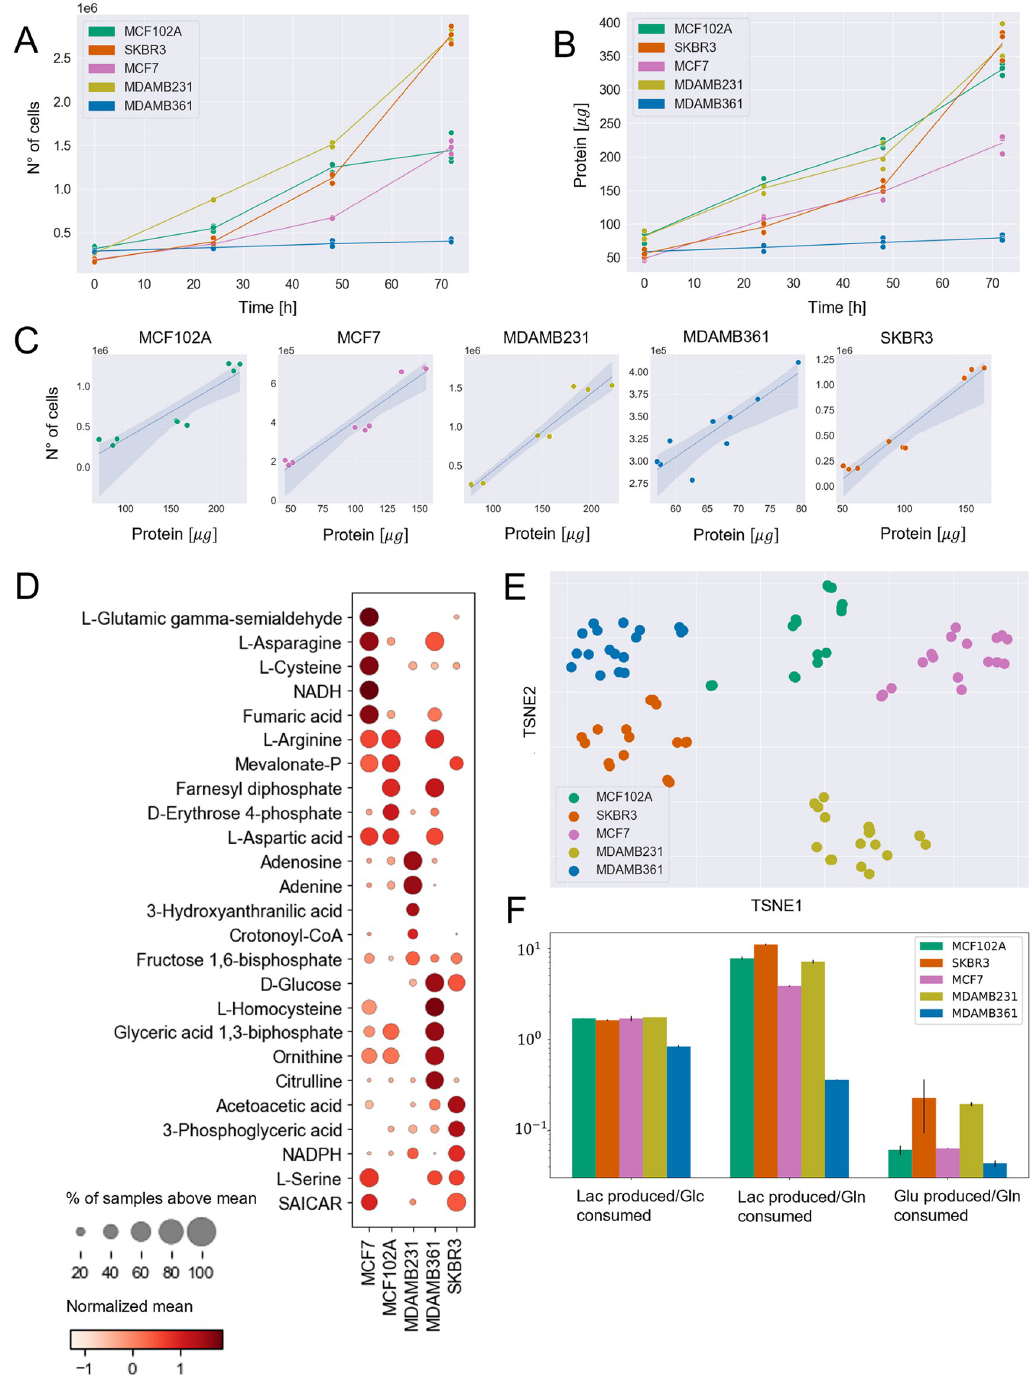
Fig 2. Experimental metabolic measurements at balanced growth phase. A) Number of cells in time. B) Protein content in time. C) Correlation plots between protein content and number of cells for experimental observations in the 0–48hrs time windows. D) Dot plot representing the normalized mean (Z-score) of the metabolite abundances within each line (visualized by color) and the fraction of samples of each cell line with the abundance over the mean of all cell lines samples (visualized by the size of the dot). The first five metabolites that better distinguish each cell line from the others, according to t-test p-value, are reported. E) t-SNE dimensionality reduction of intracellular metabolomics profiles. F) Extracellular flux ratios, derived from spent medium